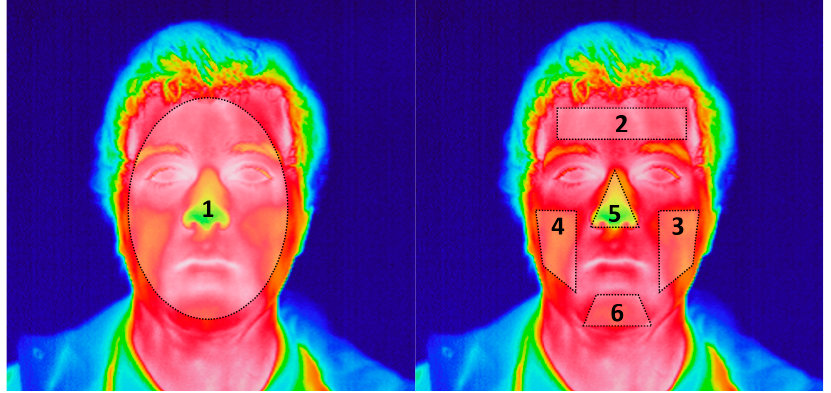
Figure 3. Regions of interest defined for the evaluation of thermal comfort: 1—face; 2—forehead; 3—cheekbone right; 4—cheekbone left; 5—nose; 6—chin.